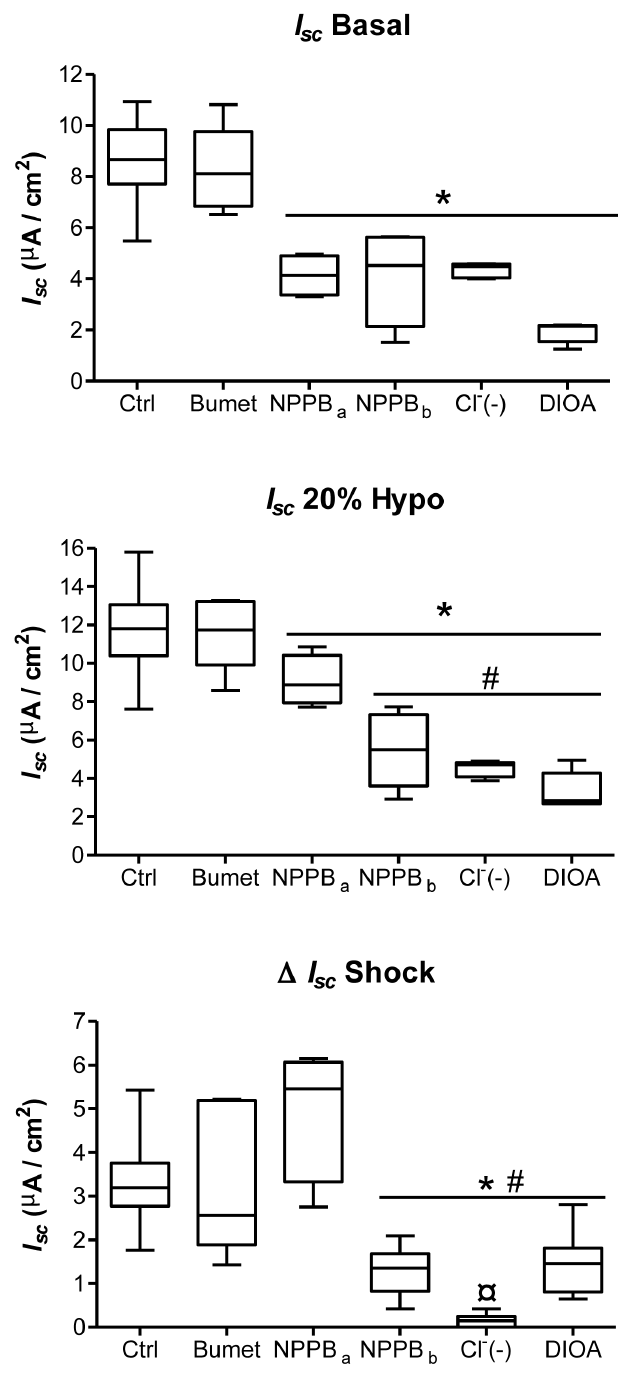
Figure 4. Implication of Cl - channels and KCC in basal and hypotonic-induced transepithelial current. Basal transepithelial current ( I Basal), hypotonic-induced current ( I 20% Hypo) and the current rise elicited by hypotonic shock (Δ I sc sc depicted in the basal conditions (Ctrl), after treatment with 100 µM basolateral bumetanide (Bumet), 100 µM apical (NPPB basolateral (NPPB ) NPPB, in bilateral Cl - reduced buffer (Cl - (-)) or 100 µM basolateral DIOA. In experiments where the cells were b pre-treated with an inhibitor that impacted on I , hypotonic shock was induced when the current was stabilized. For apical and sc basolateral NPPB, a 5 to 10 min incubation was needed while the current stabilized after ~ 30 min for DIOA. Pre-treatment with bumetanide from 10 min to 30 min did not have an impact on I Basal. N≥4, *p<0.05 by Mann-Whitney Test compared to untreated sc controls. # p<0.05 by Mann-Whitney Test compared to NPPB , ¤ p<0.05 by Mann-Whitney Test compared to NPPB a doi: 10.1371/journal.pone.0074565.g004 PLOS ONE |